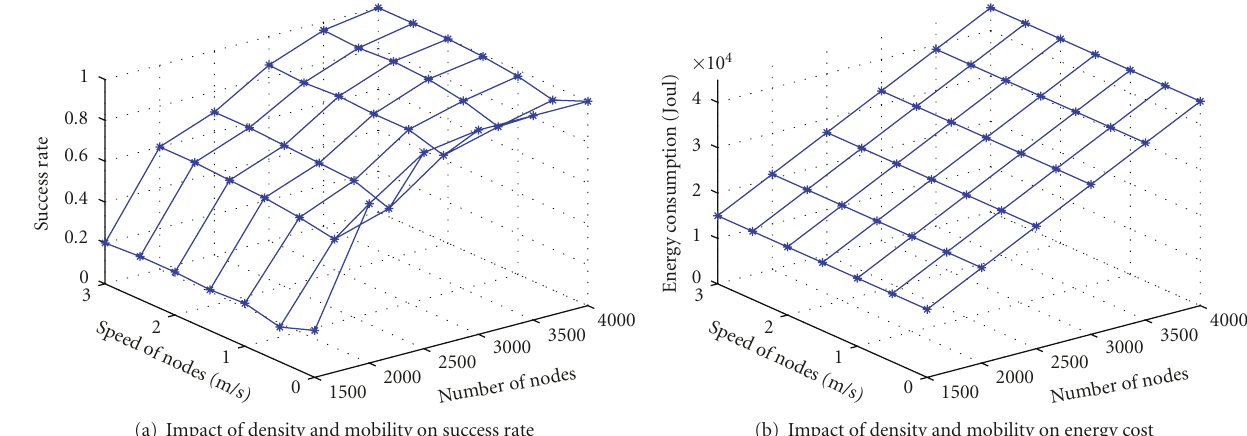
Figure 3: The performance of VBF with varying density and mobility.